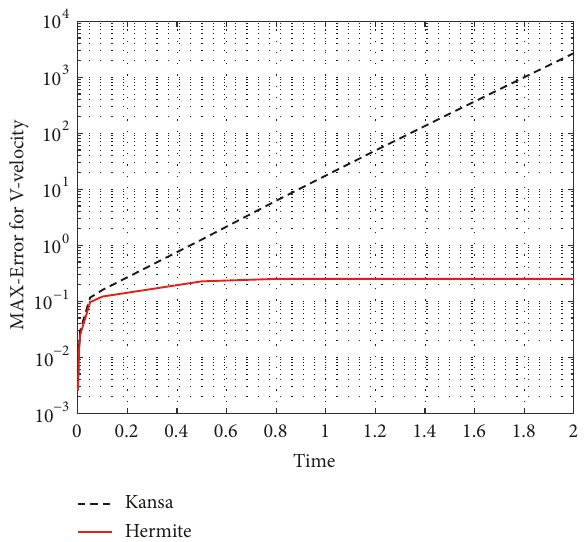
Figure 10: 𝐿 ∞ -error progression in time (0.00 ≤ 𝑡 ≤ 2.00) of the V-maximum error comparison computed at Re = 1,300 with 𝜀 = 0.005, Δ𝑡 = 0.0005 , and 𝑁 = 10 × 10